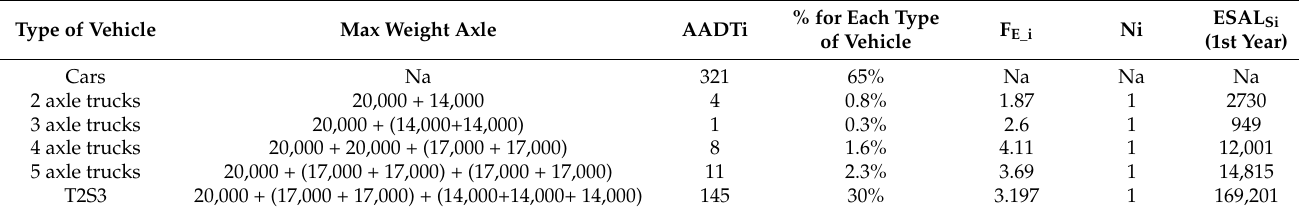
Table 3. Calculated ESALs for the different vehicles and